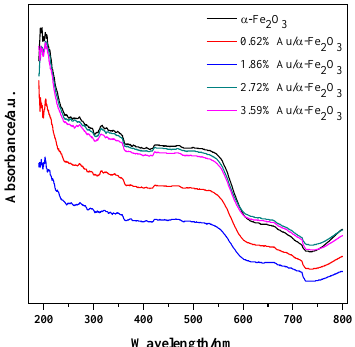
Figure 4. Ultraviolet-Visible diffuse reflectance spectra (UV-Vis DRS) of α-Fe 2 O 3 and Au/α-Fe 2 O 3 catalyst calcined at 300 °C.